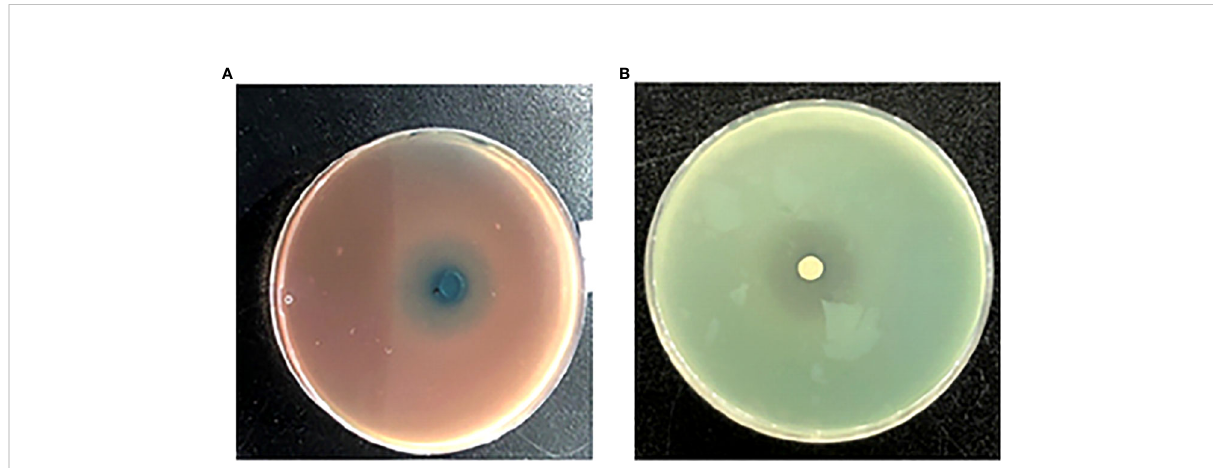
FIGURE 2 The in fl uence of 2-hydroxymethyl-1-methyl-5-nitroimidazole (HMMN) on the growth of P. aeruginosa PAO1 in Luria – Bertani (LB) broth and the CAS assay. CAS assay (A) and LB broth (B)